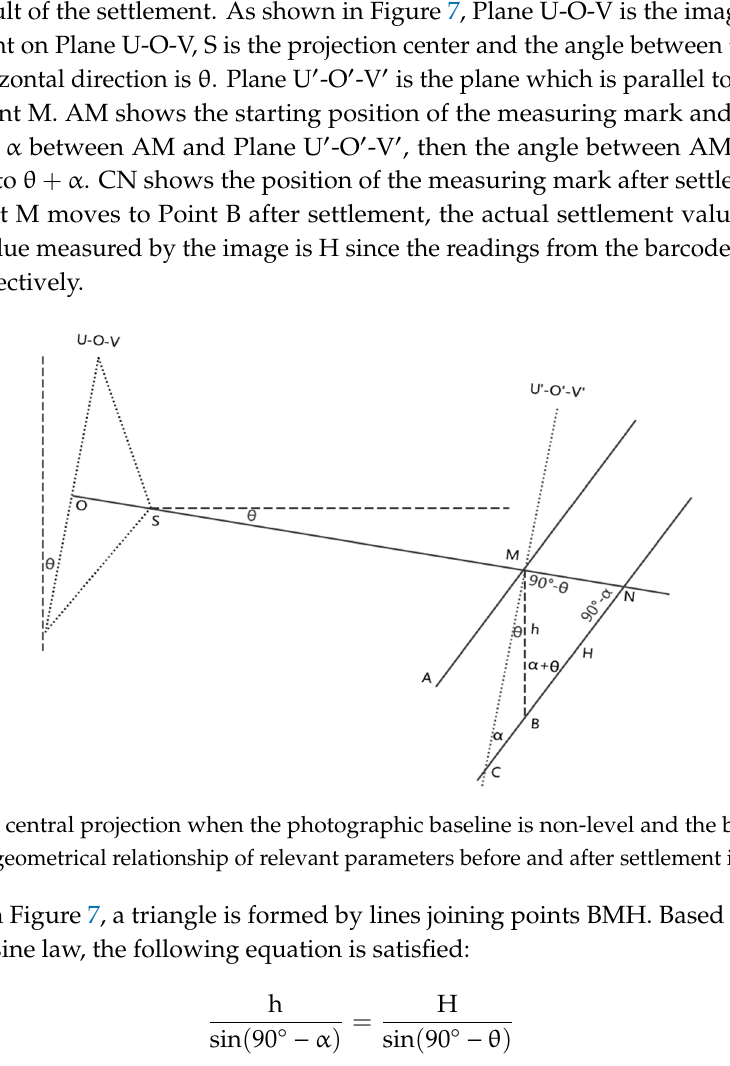
Figure 6. The influencing value from angle θ . O is the image center, S is the projection center, as OS is small enough, H and H′ are the real value and measuring value of the height of the photograph center, respectively.